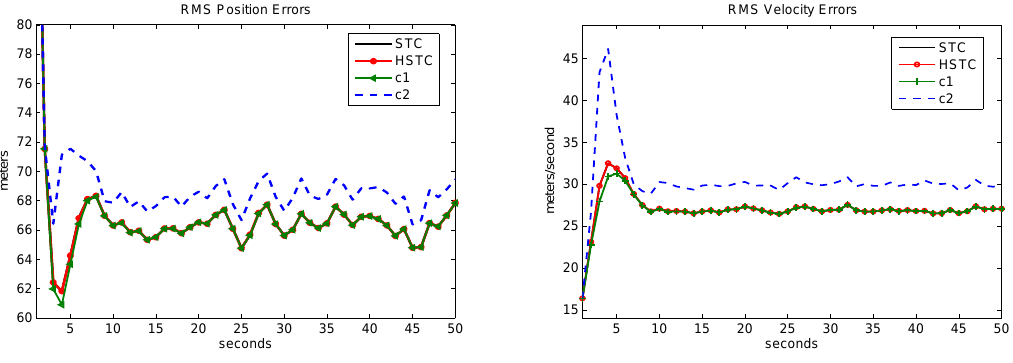
Figure 2. RMS error of position and velocity in Example